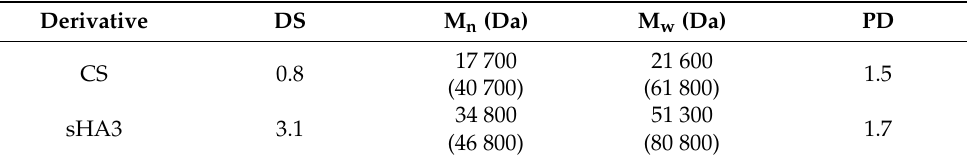
Figure 8. Polymeric GAG derivatives. Table 1. Characteristics of GAG.